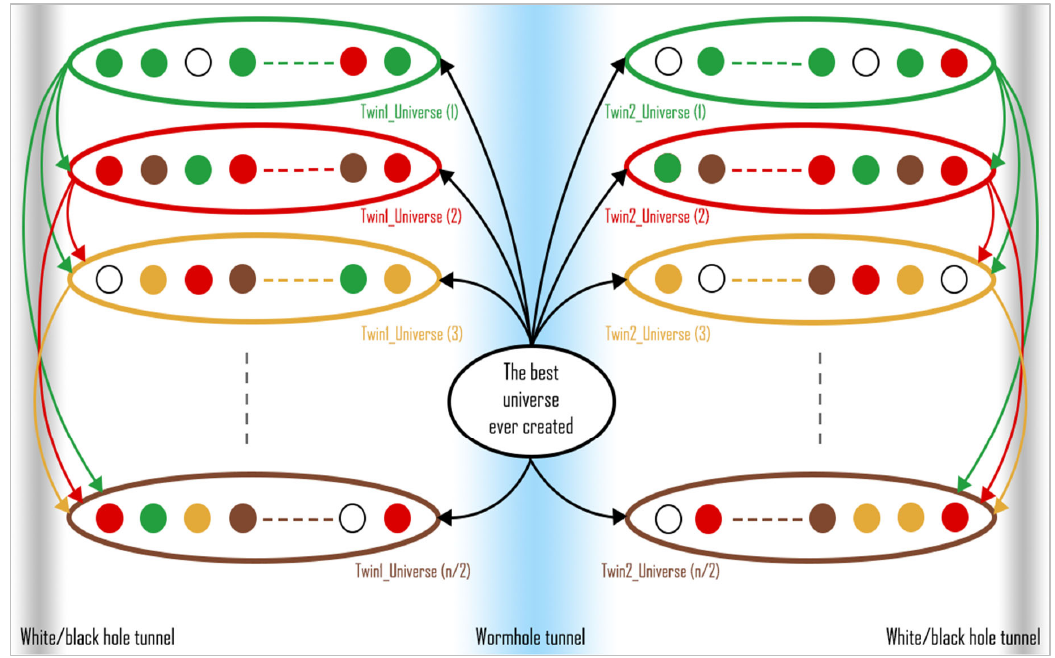
Fig. 3. Conceptional Model of MVOSANN